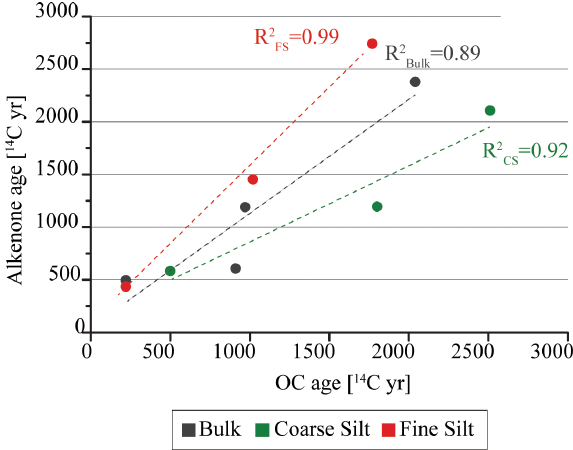
Figure 8. Relationship between OC- (Ausín et al., 2021) and alkenone- 14 C